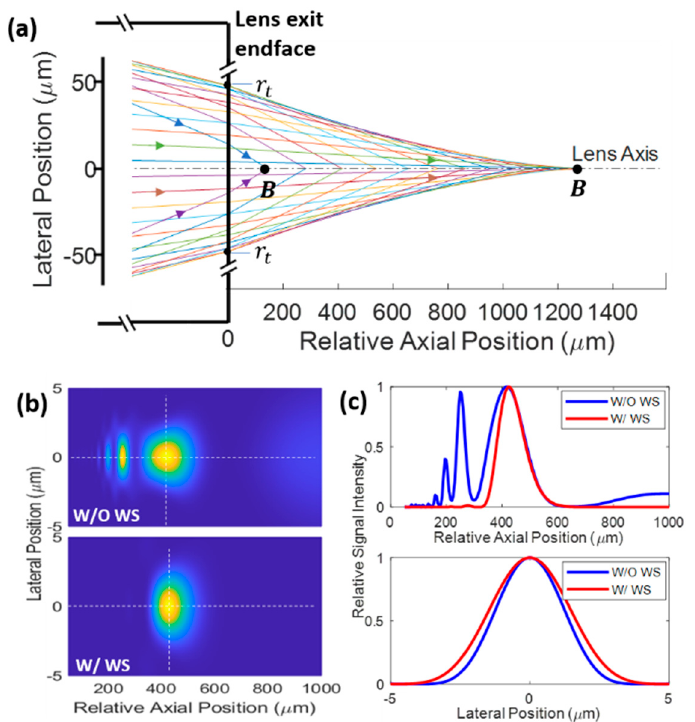
Figure 2. Simulated ray trajectories ( a ), intensity squared pattern I f ( b ), and the intensity profile ( c ) along the while dotted lines in ( b ). Simulation parameters Z 0 = 705 mm, ρ = 250 µ m, NA = 0.1, n co = 1.5, n m = 1, λ = 1040 nm and f = 450 µ m are shown in ( c ); see main text for all the